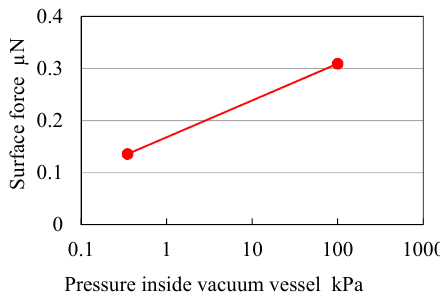
Figure 12. Relationship between pressure inside vacuum vessel and surface